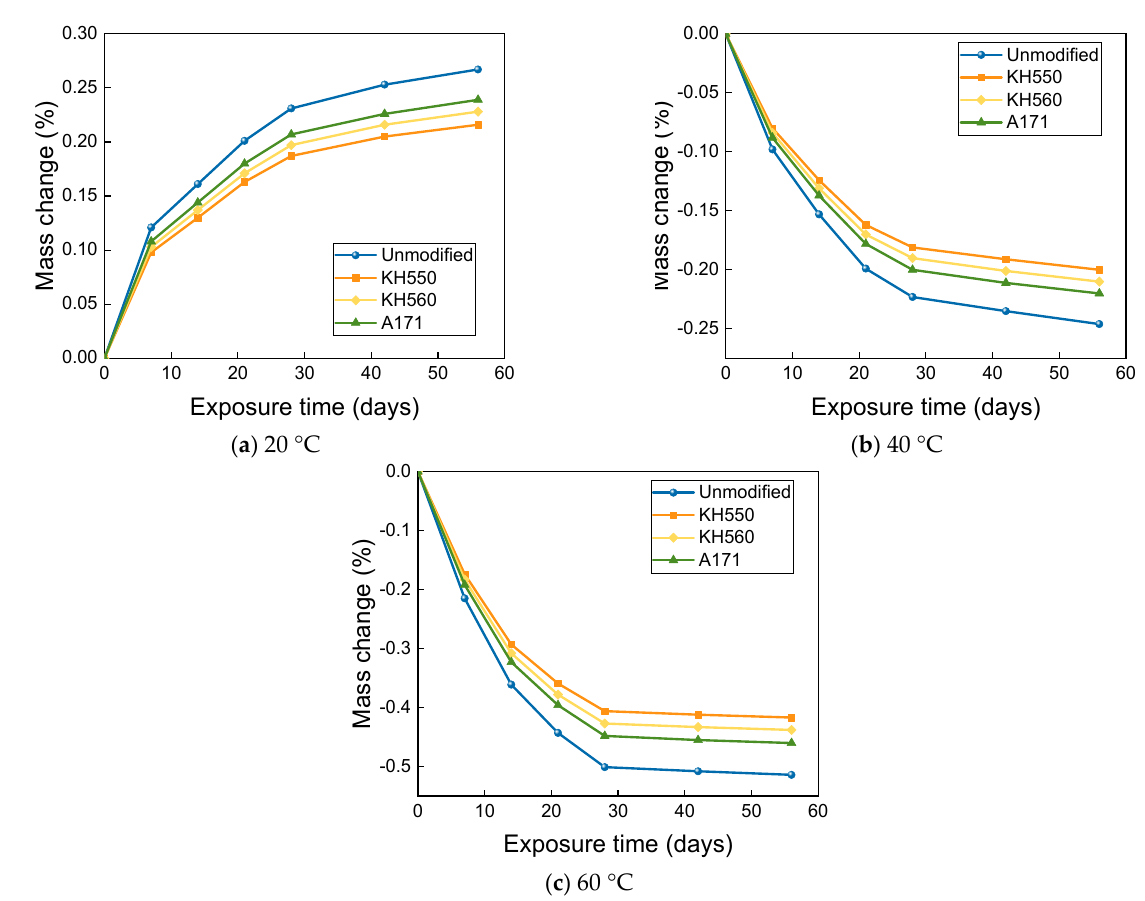
Figure 15. Mass change in a 10% H 2 SO 4 acidic environment. As can be seen from Figure 16, the mass change of BFRPs soaked in 10% NaOH alkaline environments at different temperatures increased very rapidly at the initial stage of soaking, and the mass of the BFRPs still increased at the later stage of soaking, but the growth rate slowed down. After 56 days of immersion in alkaline environments at 20 °C, the mass of BFRPs unmodified and modified by KH550, KH560, and A171 silane coupling agents increased by 0.328%, 0.260%, 0.275%, and 0.290%; after 56 days of immersion in alkaline environments at 40 °C, the mass of unmodified and KH550, KH560, and A171 silane-coupling-agent-modified BFRPs increased by 0.698%, 0.555%, 0.587%, and 0.619%; the masses of BFRPs unmodified and modified by KH550, KH560, and A171 silane coupling agents increased by 1.579%, 1.256%, 1.331%, and 1.402% after 56 days of immersion in alkaline environments at 60 °C. The mass change of BFRPs immersed in the alkaline environments was greater than in all other corrosive aging environments. This may be due to the penetration of the high pH solution, resulting in more microcracks and greater moisture uptake, which leads to greater weight gain. Similar results were reported by Karbhari and Chu [38], who compared the weight gain of glass/vinyl ester composites submerged in different solutions. When the composite samples were submerged in water, seawater, and alkaline solutions, the water molecules in these solutions penetrated the Figure 16. Cont composites, increasing the mass of the samples.